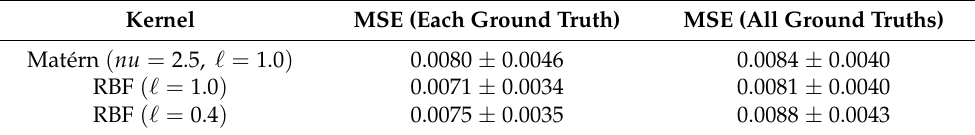
Table A5. MSE of the hyper-parameter optimization using different